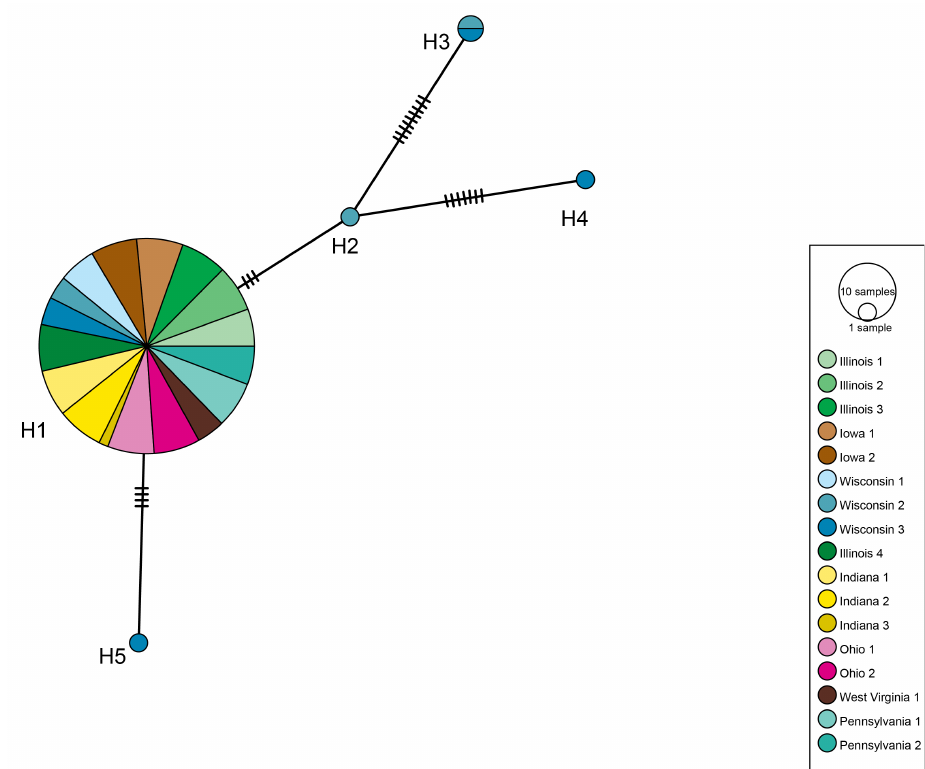
Figure 4. TCS (Templeton-Crandall-Sing) network depicting relationships between COI haplotypes of Depressaria depressana collected from sites sampled along both the latitudinal gradient from Urbana, IL to Eau Claire, WI and the longitudinal gradient from Urbana, IL to Newburg, PA. The size of each circle represents number of individuals belonging to each haplotype (H1–5). The number of hash marks on branches between haplotypes represent the number of mutational